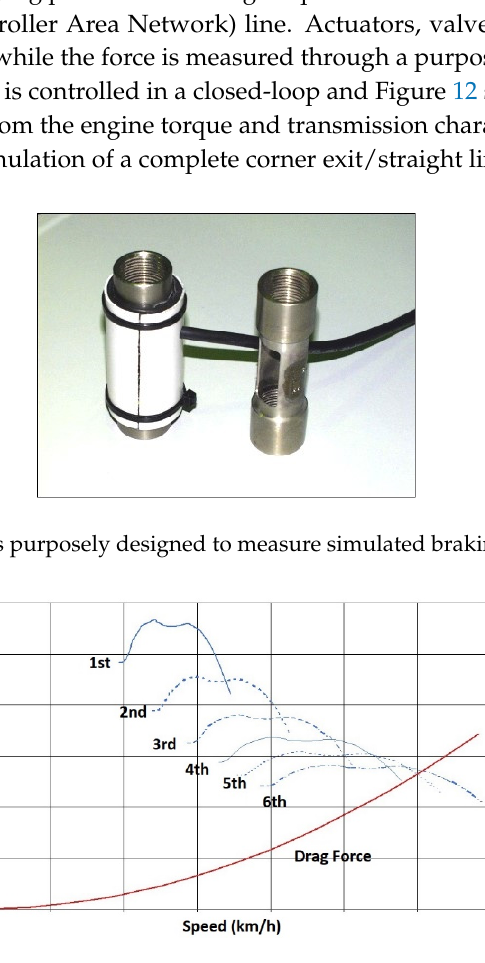
Figure 12. Power torque curves and transmission characteristics used to simulate the acceleration